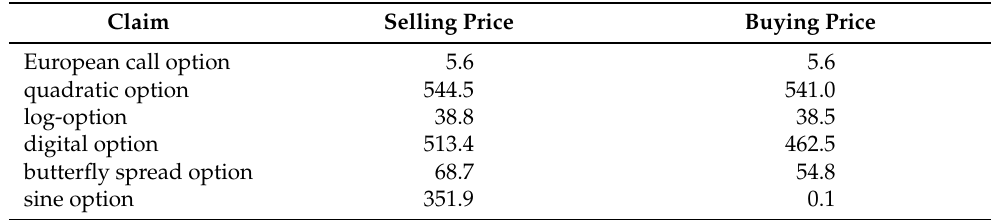
Table 5. Indifference